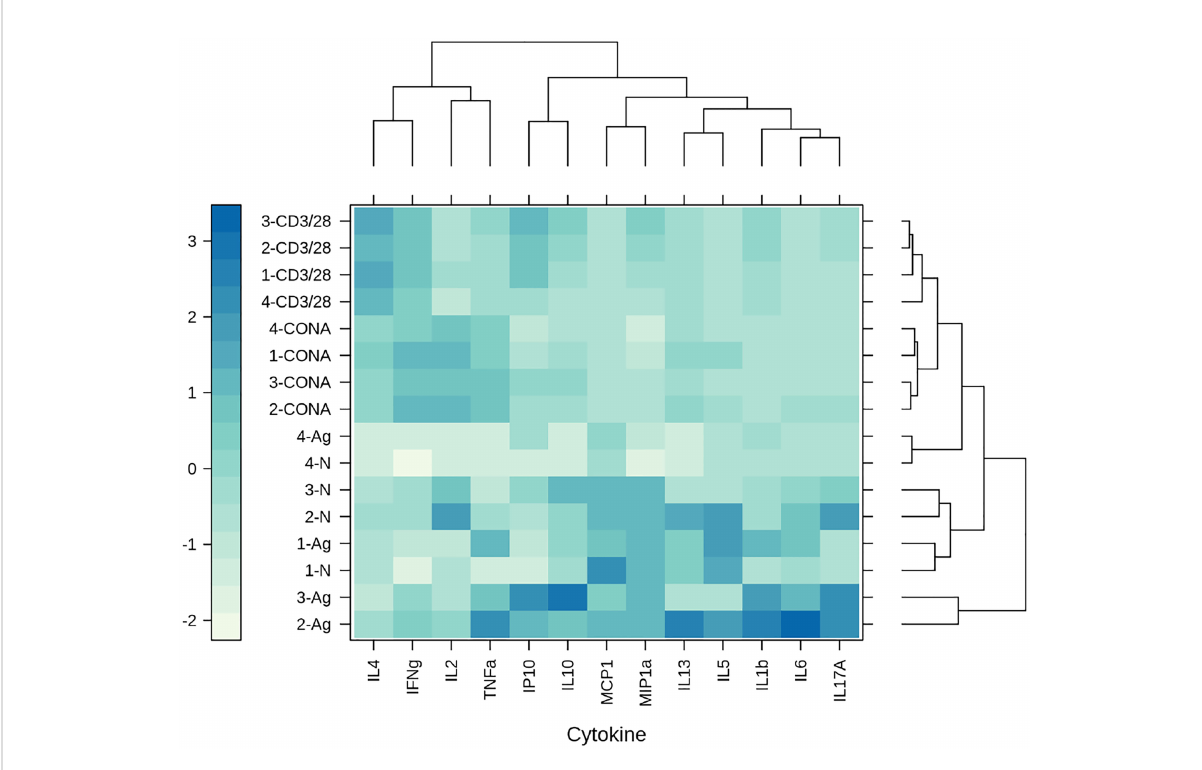
FIGURE 6 The clustered heatmap of the cytokine secretion triggered by mammalian cell-derived HVB-S/preS1 16-42 and HVB-S antigens. Group of fi ve mice were immunized 3 times, at 14-day intervals with HEK293T background protein (1), HVB-S/preS1 16-42 (2), HBV-S (3) and Al(OH) 3 adjuvant only (4). Cytokine levels were measured in spleen cells harvested from mice of each group (1-4) after stimulation with UV-inactivated HBV (Ag) and compared with unstimulated cells (N). Concanavalin A (CONA) and CD3/CD28 antibodies (CD3/28) were added as positive controls for the in vitro stimulation assay (n=5). Clusters and dendrograms were automatically generated, by using the hclust - manhattan and wald.D2 methods, respectively, in Rstudio (version 1.4.1103, the latticeExtra and dendextend packages). Columns and rows of the heatmap matrix show the analyzed cytokines and the stimulation agents, respectively. The blue and white colours indicate high and low levels of cytokine secretion,